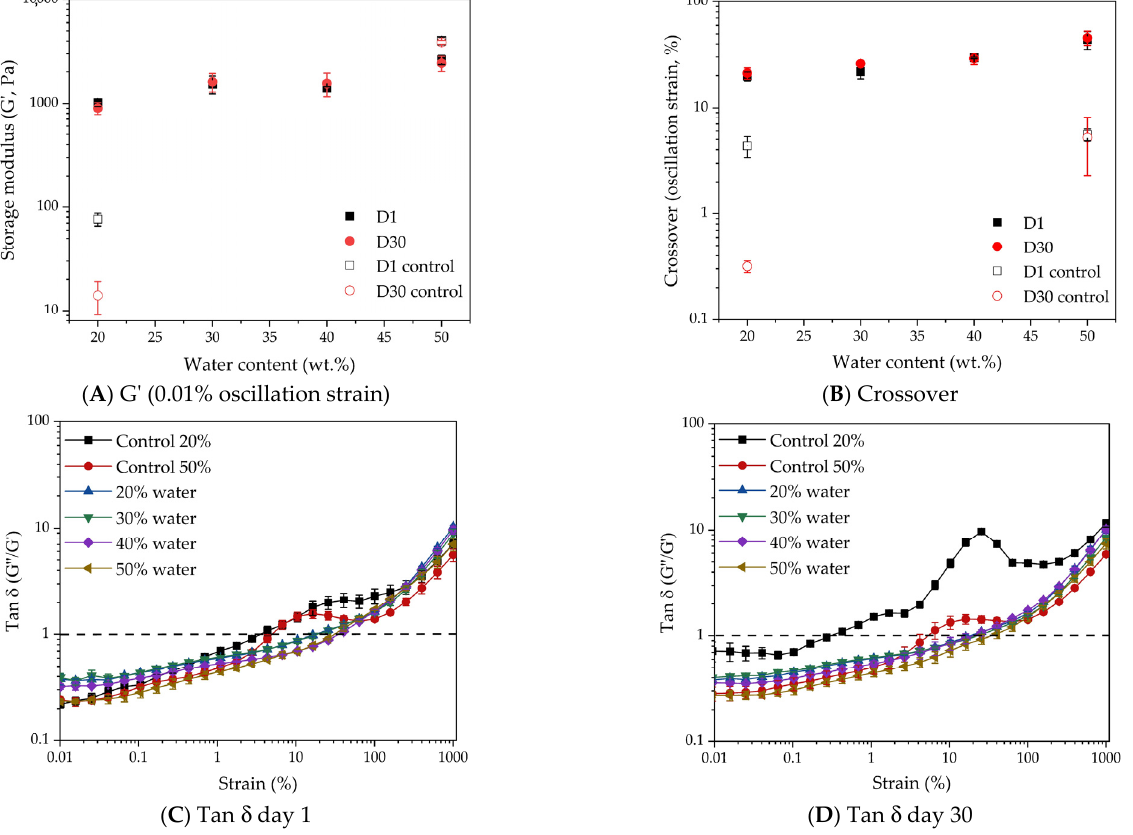
Figure 5. Storage modulus (G (cid:48) ) at 10% of oscillation strain ( A ), crossover (% strain) ( B ), and the values of tan δ on day 1 and day 30 ( C , D , respectively) of water-in-oil emulsions as a function of oscillation strain with different water volume fractions prepared with LMP, GMO, and HSO on day 1 (D1) and day 30 (D30). Note the difference in y-axis scales due to the variation of